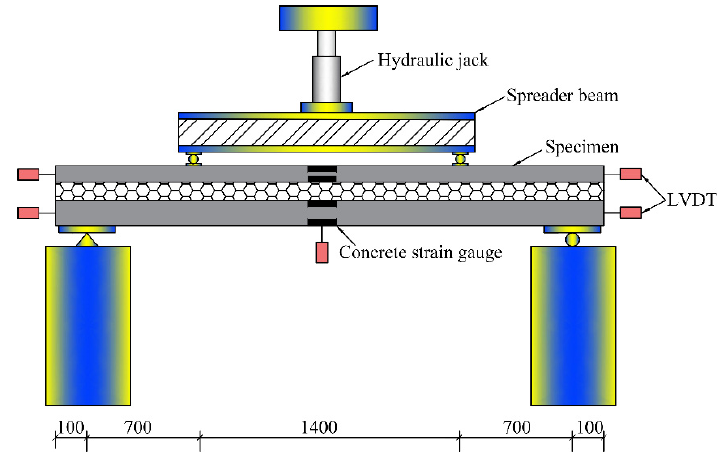
Figure 5. Schematic diagram of test loading device.